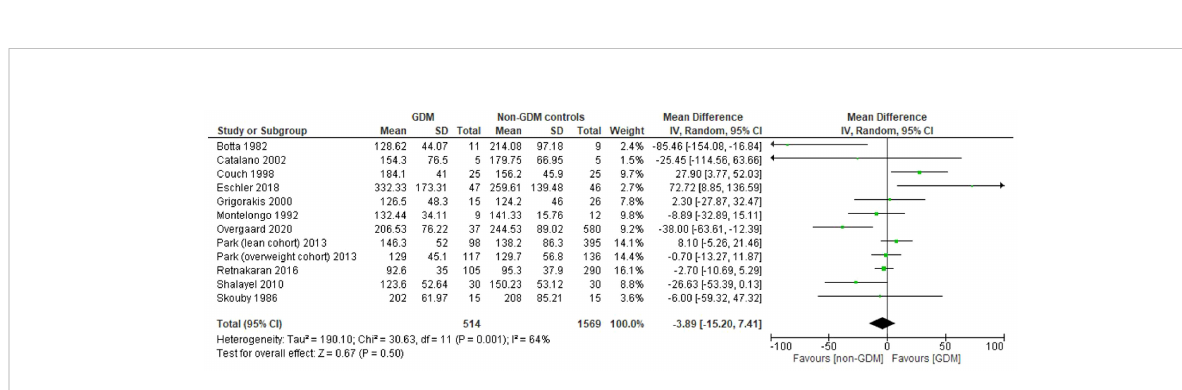
FIGURE 2B Forest plot showing meta-analysis of PRL levels in GDM vs non-GDM control women in late pregnancy (>24 weeks) – 11 studies.